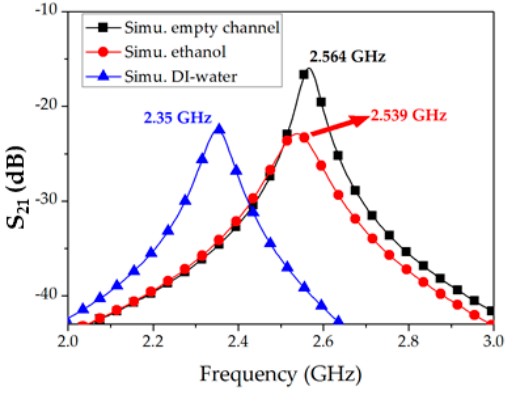
Figure 7. Simulation analysis of our proposed microwave resonator working as a chemical sensor. S 21 corresponding to empty channel, ethanol, and deionized water (DIW) are shown.